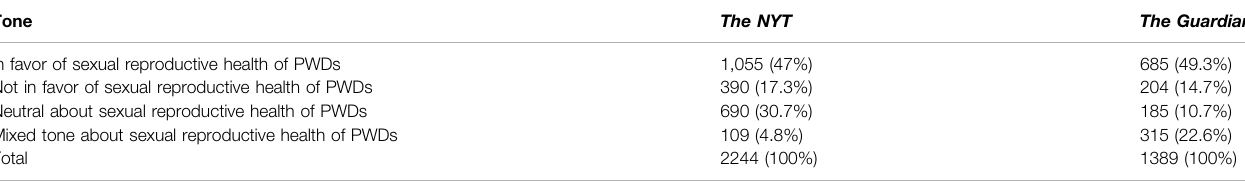
TABLE 4 | Differences and similarities in commenters tone in both